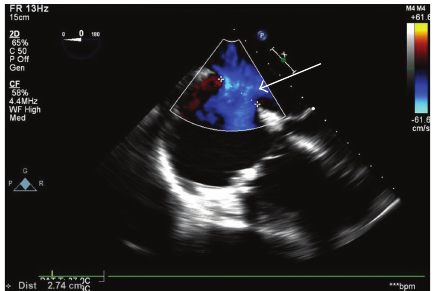
Figure 1: Mitral valve vegetation (arrow).